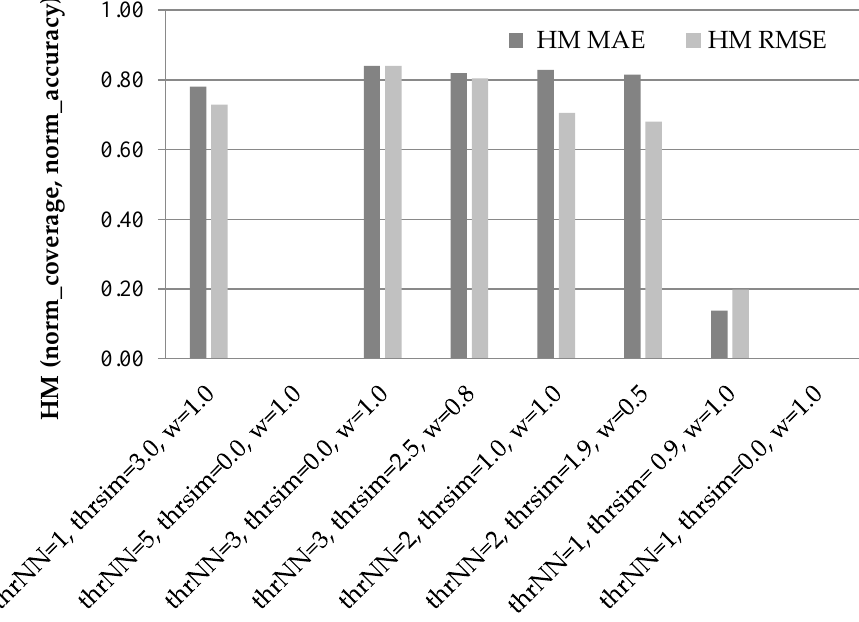
Figure 3. Harmonic Mean of the normalized accuracy and coverage increase measures for the candidate setting, when using the PCC as the similarity metric.